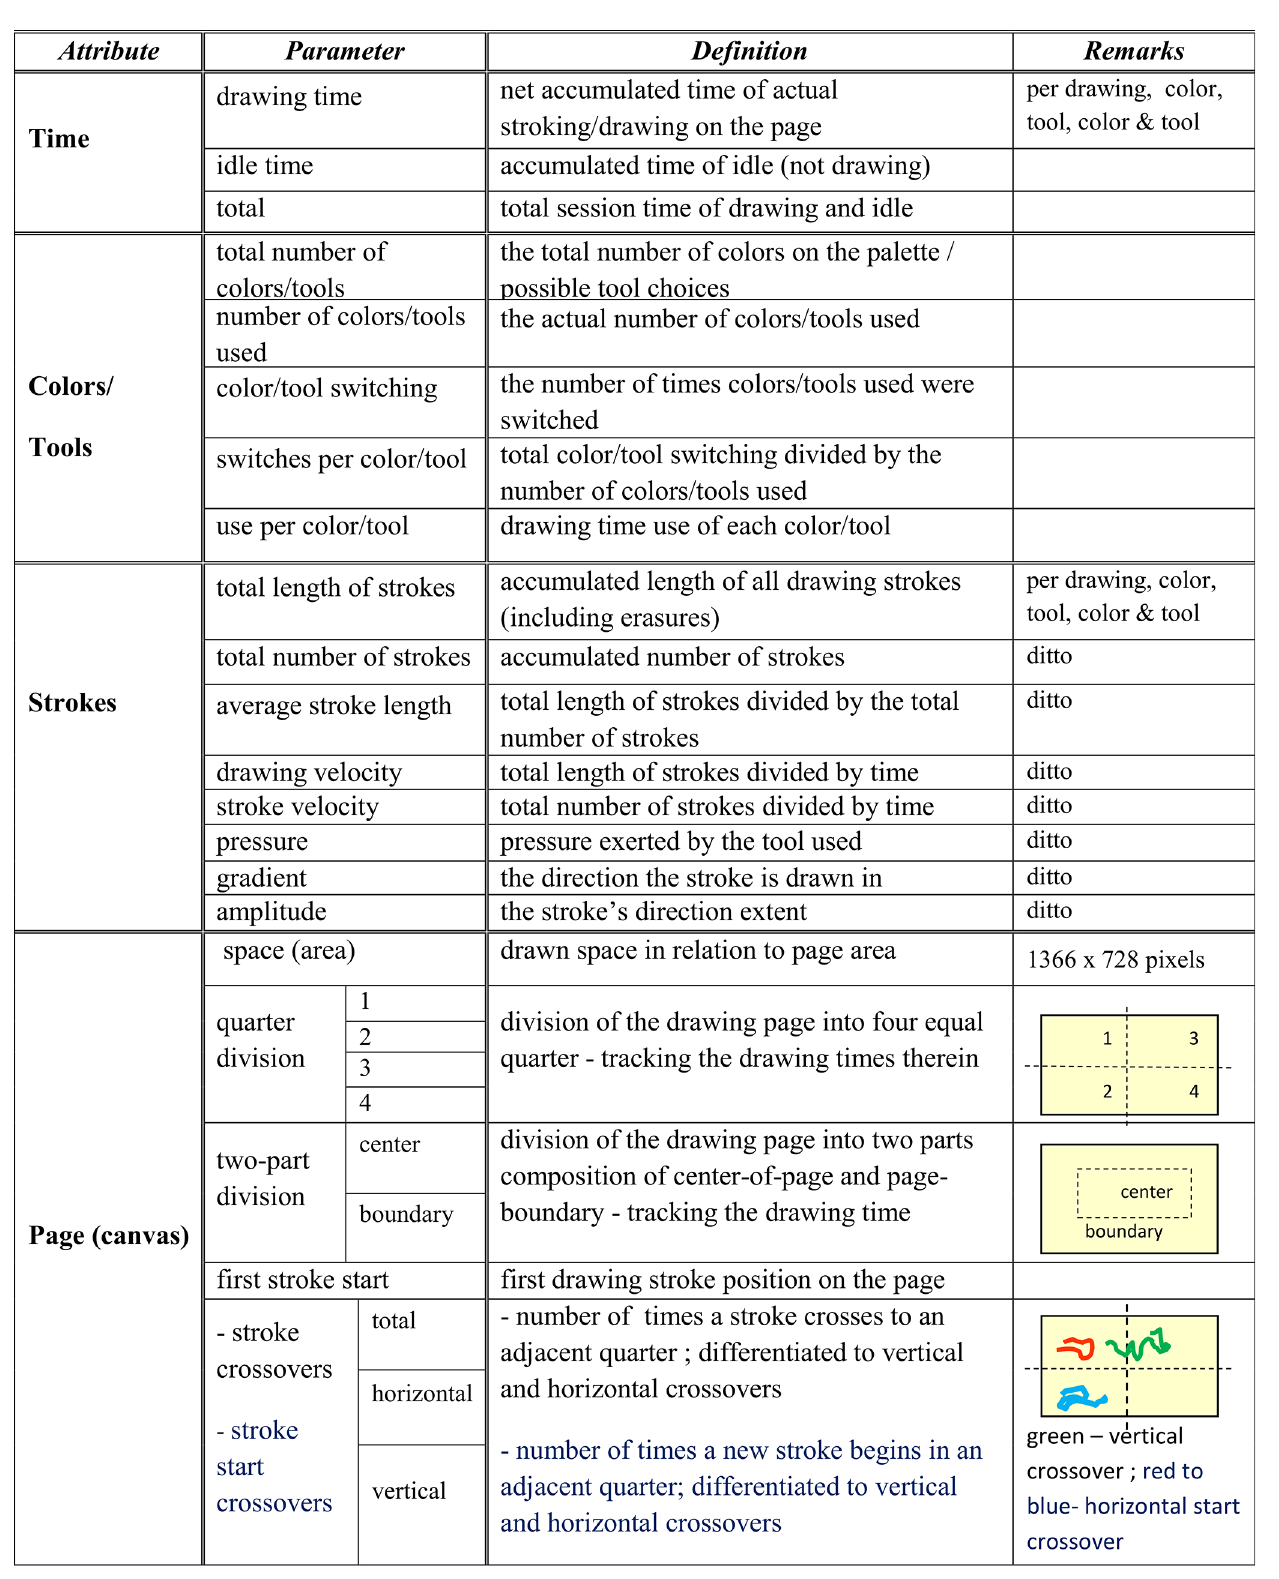
Fig 5. The table defining the parameters/metrics of the Artwork's construction